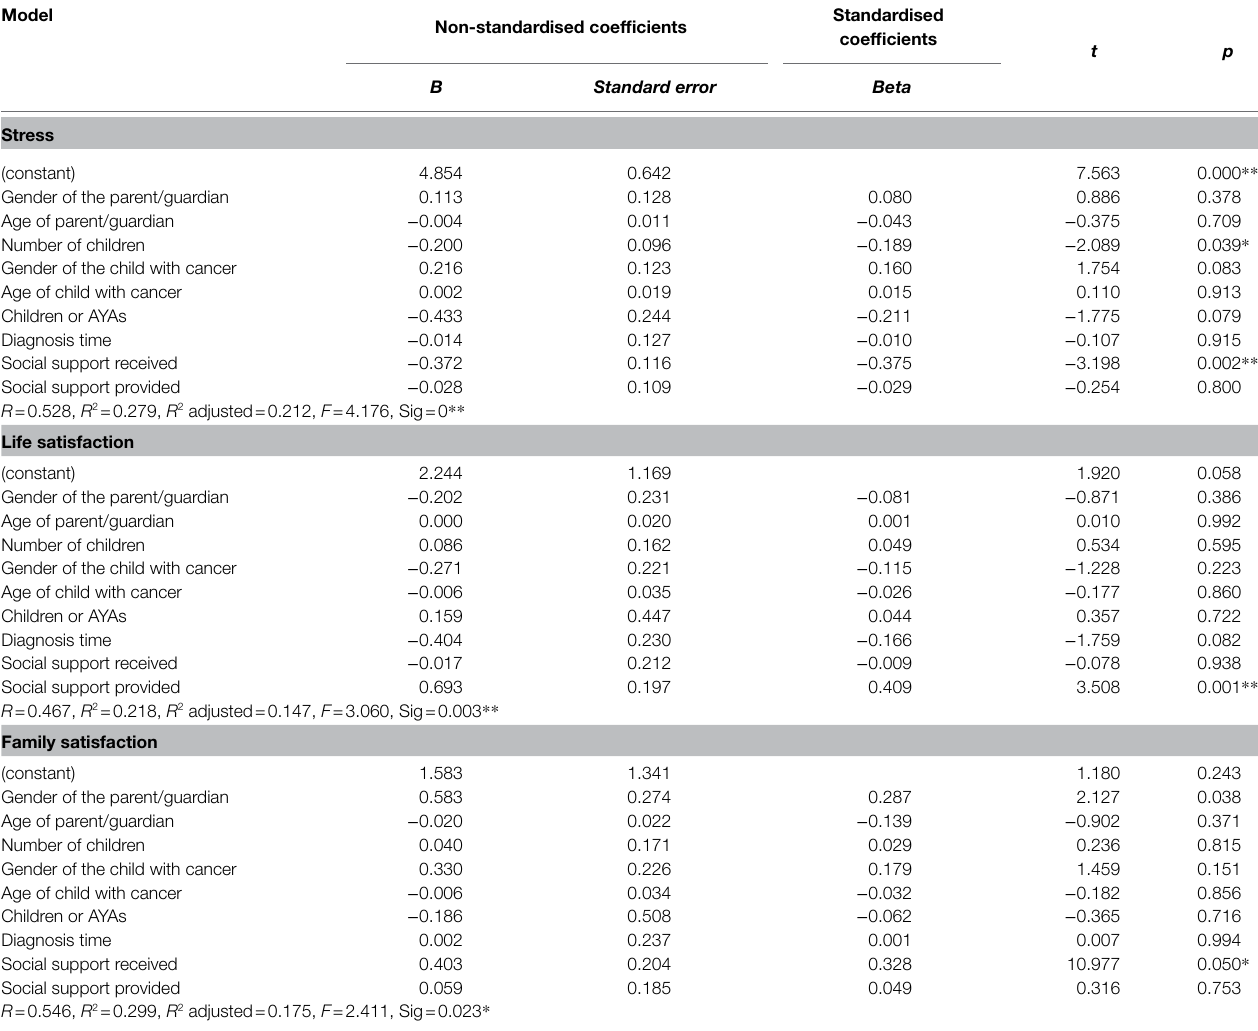
TABLE 7 | Multiple linear regression analysis for stress, life and family satisfaction ( n = 112).